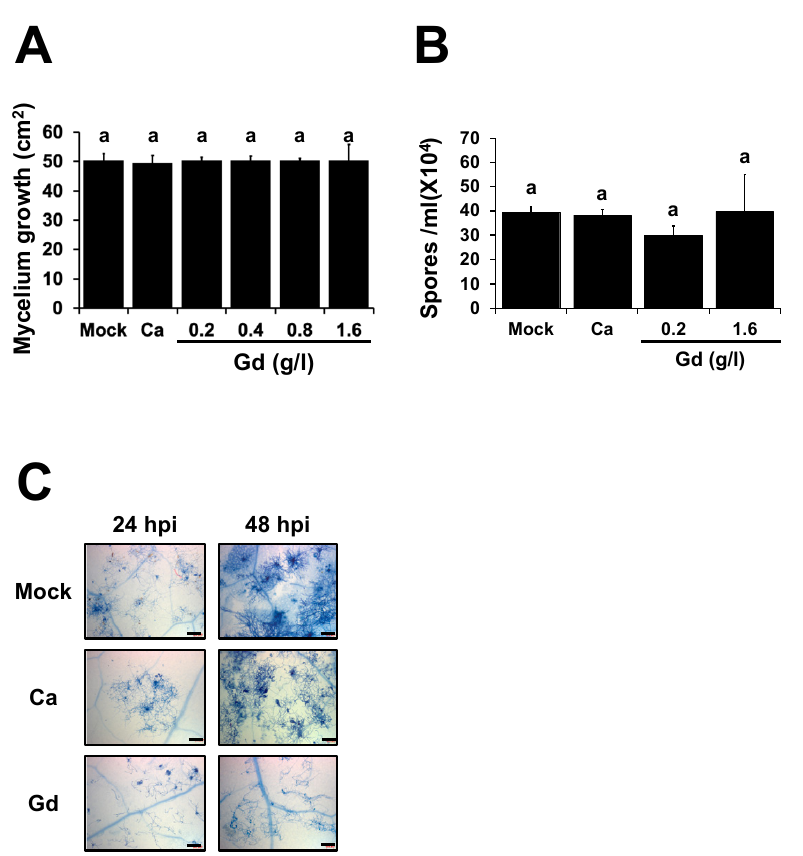
Figure 2. Gd does not affect the growth and development of B. cinerea . ( A ) A total of 5 µ L of spore suspension of B. cinerea (5 × 10 4 spores mL − 1 ) was placed on the center of the Petri dish containing PDA supplemented with water (mock), 0.2 g/L Ca, and the indicated concentrations of Gd and incubated at 22 ◦ C. Growth inhibition was evaluated by measuring the diameter of the mycelium on the dish 3 days post inoculation. ( B ) Spores produced by B. cinerea 10 days after growth on a Petri dish containing PDA supplemented with mock, 0.2 g/L Ca, and the indicated concentrations of Gd were isolated and quantified as previously described [33]. ( C ) B. cinerea development over A. thaliana -infected leaves was determined by trypan blue staining at 24 and 48 hpi. Representative images were selected as a visual illustration from two independent experiments. Bars represent mean values ( ± SD) of three independent experiments. Scale bar = 200 µ m. Different letters above each bar represent statistically significant differences according to the Scott–Knott test ( p < 0.05).